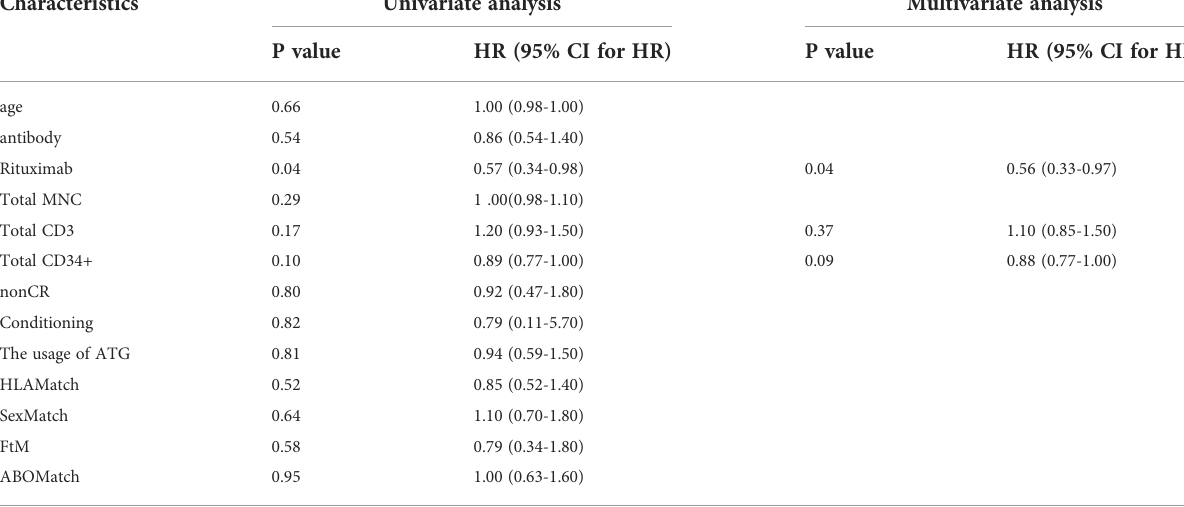
TABLE 4 Risk factors for aGVHD in AML patients.